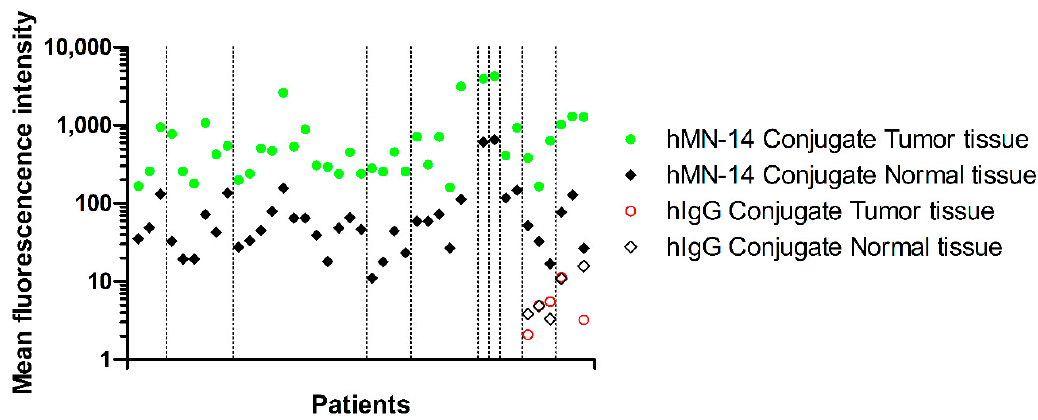
Figure 1. Mean fluorescence intensity (arbitrary units) per pixel for tumor (green dots) and normal tissue (black diamonds) in individual tumors. Each green circle represents an included tumor. Vertical dashed lines separate patients. Note the higher fluorescence signal in all tumors compared to surrounding normal tissue ( p < 0.001). The control condition (incubation with the non-specific antibody-conjugate DOTA-hIgG-IRDye800CW) shows no significant di ff erence between tumor and normal tissue tracer accumulation (red circles and black open diamond; last two patients).